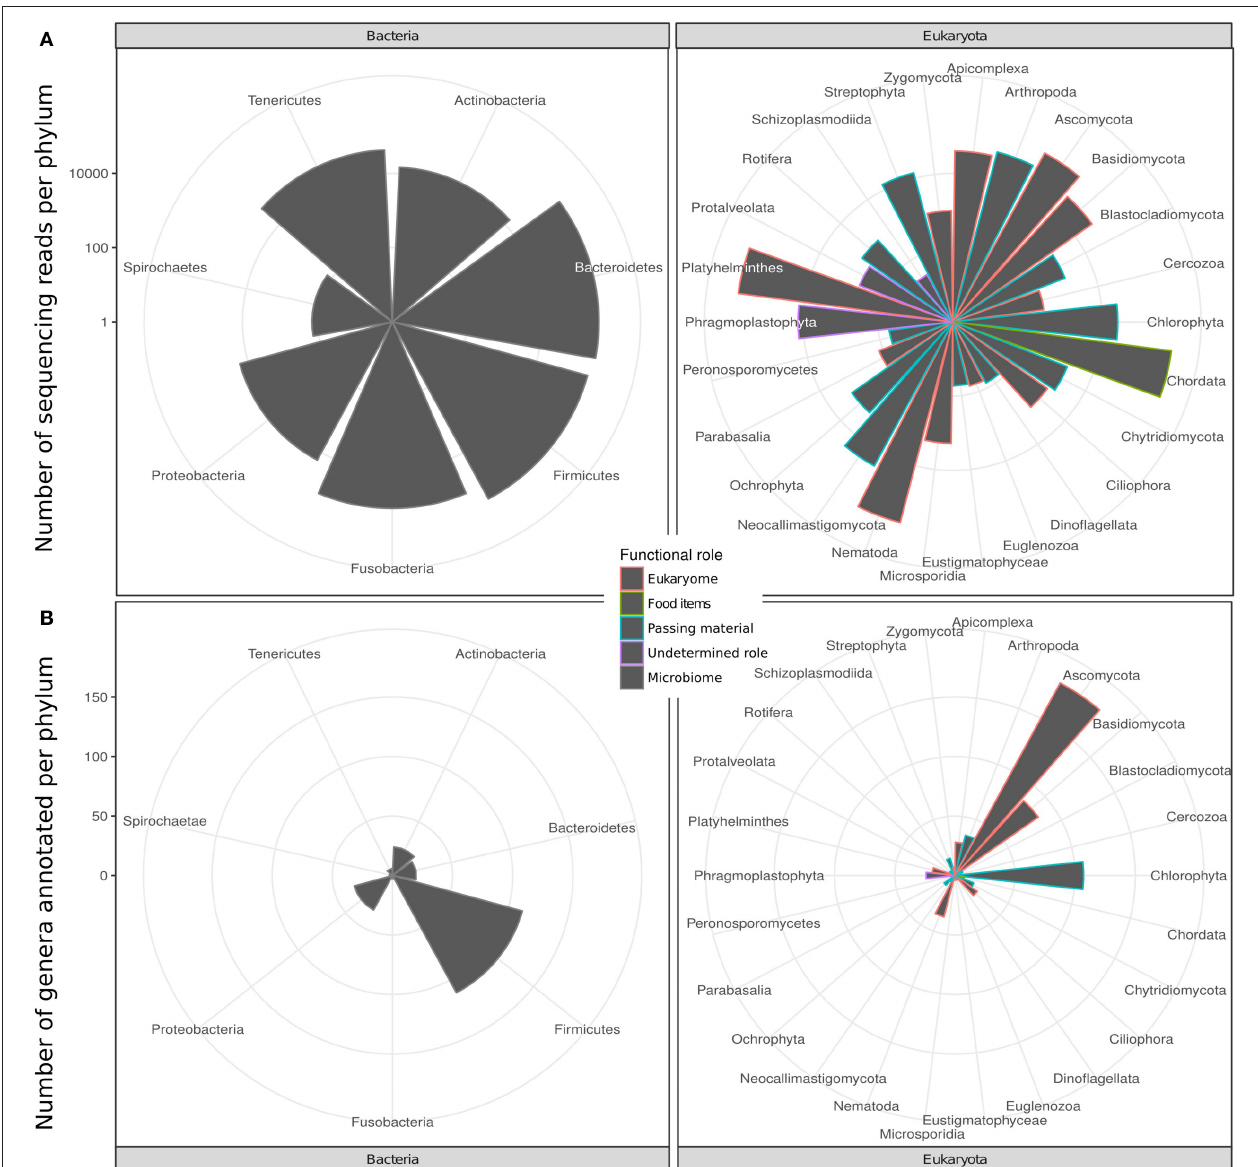
FIGURE 1 | Taxonomic diversity of the intestinal bacterial microbiome and eukaryome of the spotted hyena in terms of (A) number of genera and (B) number of sequence reads inferred for different phyla of bacteria and eukaryotes from taxonomically annotated multi-amplicon sequencing reads. Bars are colored according to the likely predominant interaction with their host conventionally assumed for these taxa (see main